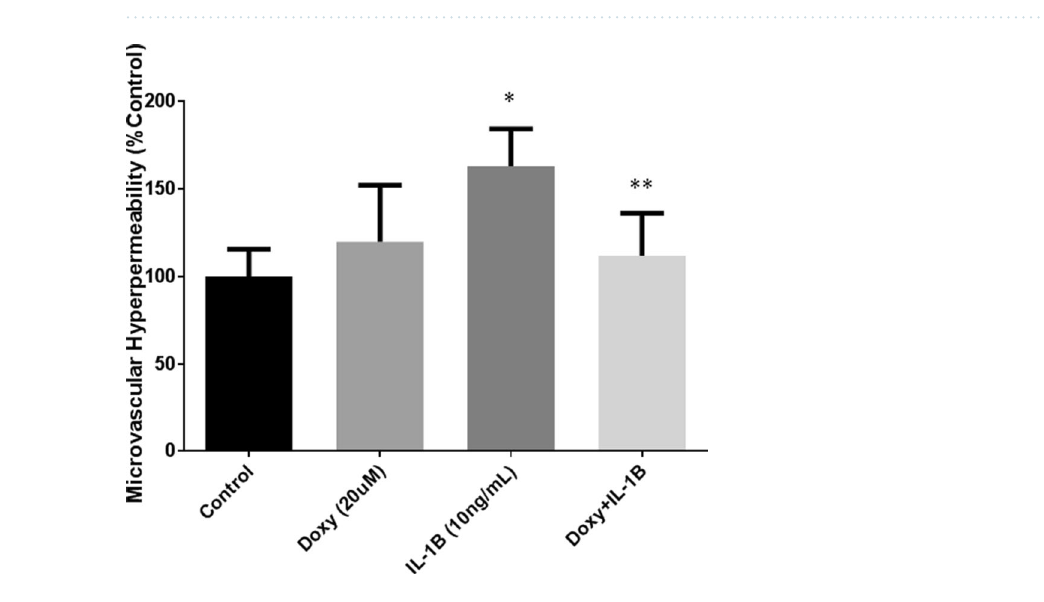
Figure 3. Determination of monolayer permeability using Transwell assays. Doxycycline decreased IL-1β- induced microvascular endothelial cell monolayer hyperpermeability. IL-1β induced hyperpermeability significantly, compared to untreated control group in this model (* p < 0.05; n = 5). Pretreatment with Doxycycline mitigated this effect compared to IL-1β group (** p < 0.05; n =